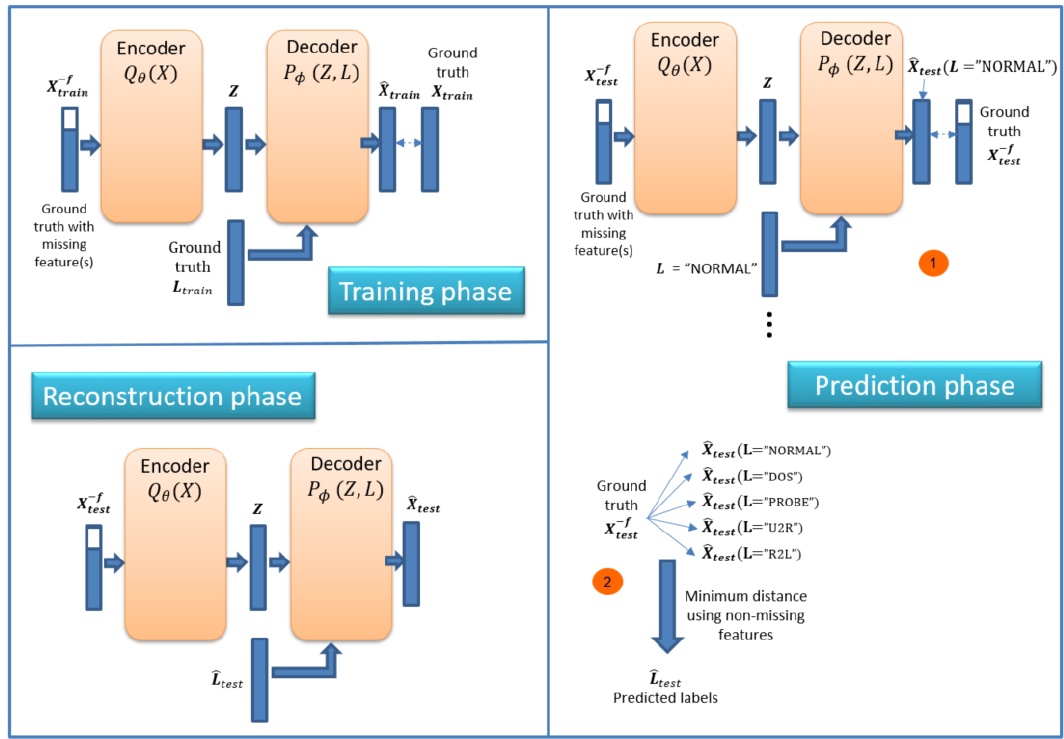
Figure 7. Feature reconstruction framework.